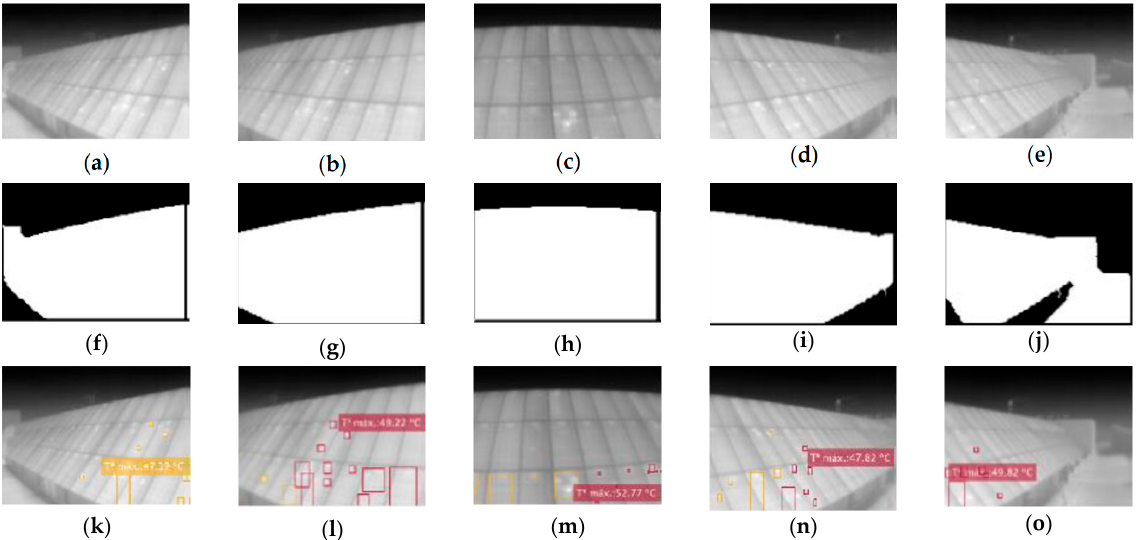
Figure 18. Variation of the horizontal angle ( − 35 ◦ , − 15 ◦ , 0 ◦ , 15 ◦ , 35 ◦ ) for the distance of 3 m. ( a – e ) Raw images; ( f – j ) segmented images; ( k – o ) final